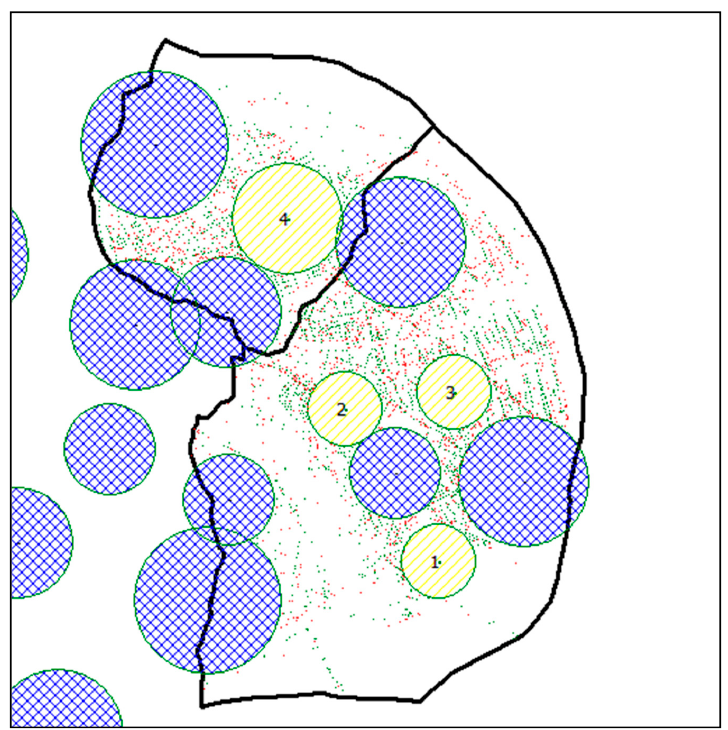
Figure 5. The four new floating stations suggested, with existing fire stations and uncovered EMS points with a capacity of 100 incidents per year during peak periods.